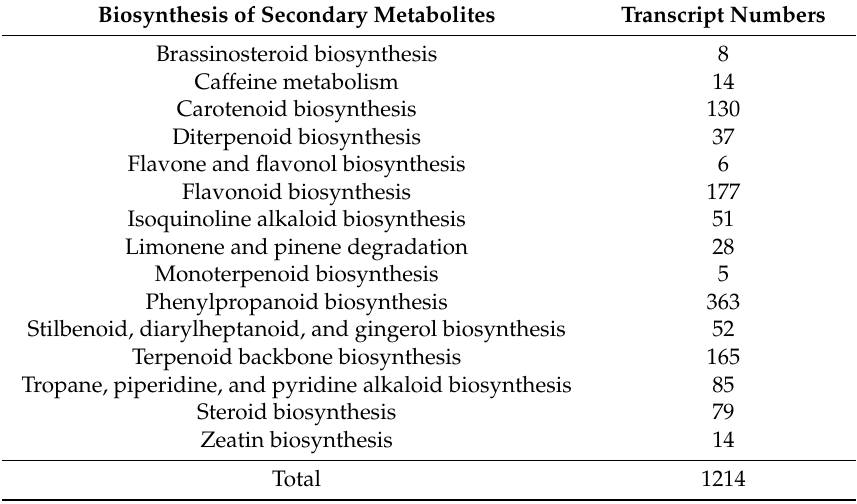
Table 3. The transcripts related to secondary metabolites.